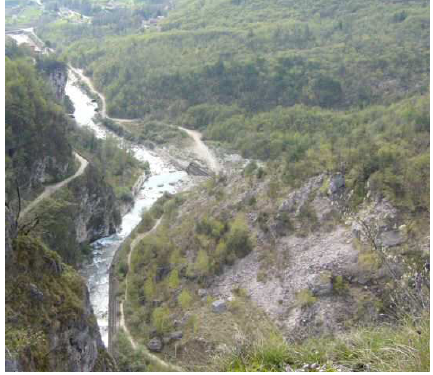
Figure 2: View of the bottom side of the landslide.